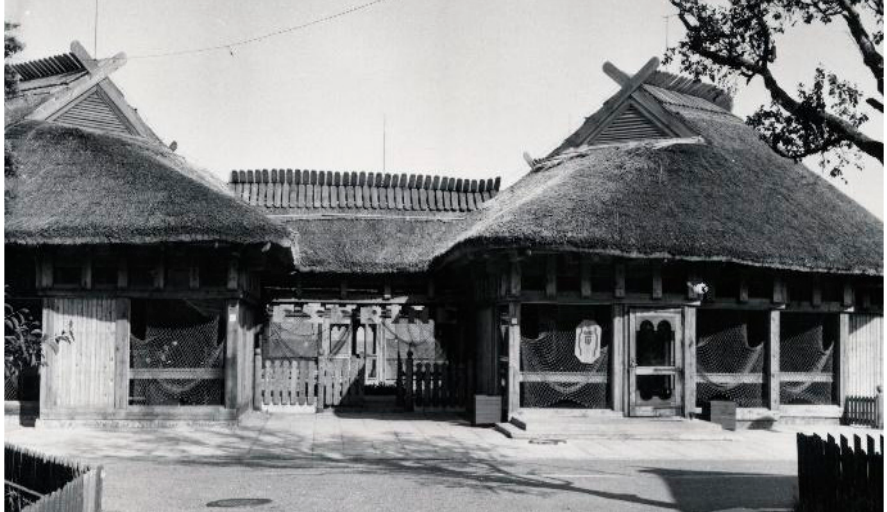
Figure 9. Restaurant “Ešerin˙e” in Nida, designed by Vaidotas Guogis, built in 1977. From the archive of the Institute of Architecture and Construction.